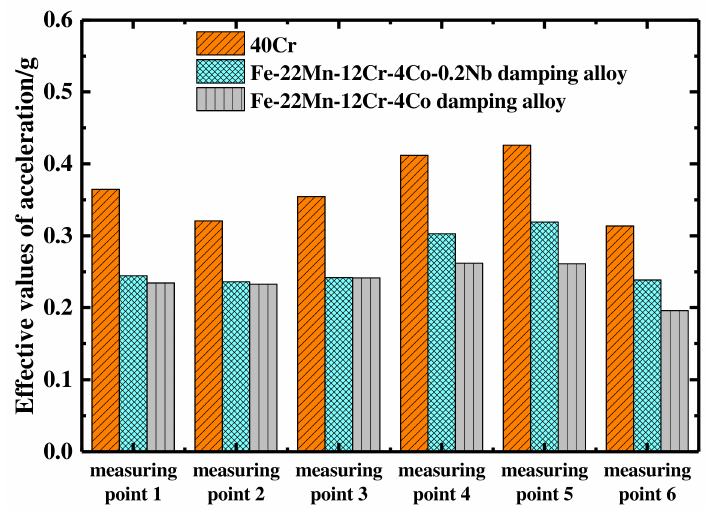
Figure 17. Effective values of acceleration at measuring points.